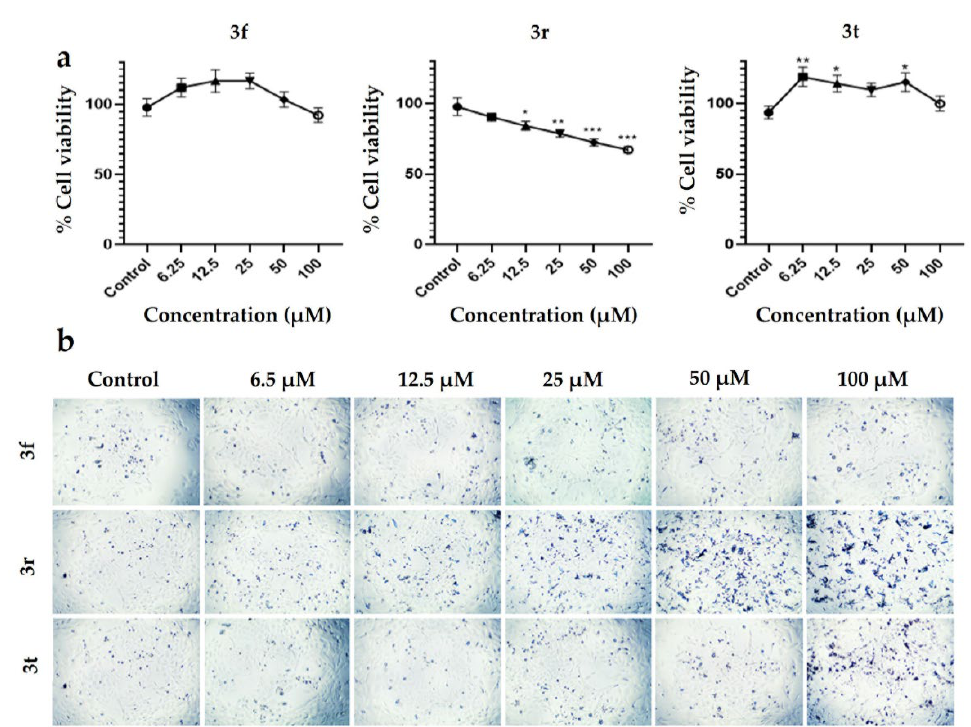
Figure 8. Cytotoxic effects of 3f , 3r and 3t compounds at 48 h on PC12 cell line. ( a ) The cell viability by MTT assay for 3f , 3r and 3t compounds on PC12 cells. ( b ) PC12 morphology posttreatments of 3f , 3r and 3t compounds at 6.25, 12, 25, 50, and 100 μM after 48 h at 4× magnification. In the plots, each point represents mean with SEM. (* p < 0.05, ** p < 0.001, *** p < 0.0001), using Dunnett’s multiple comparisons test between different concentrations and the control.